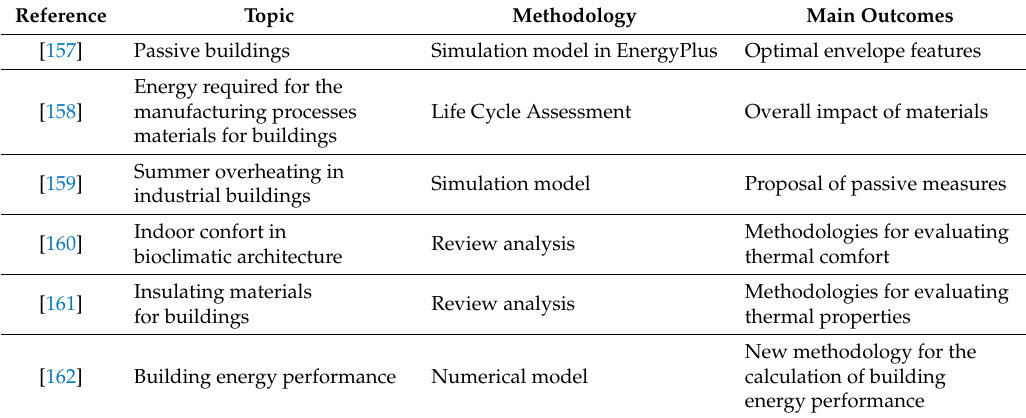
Table 5. Main topics, methodologies and outcomes of the previous SDEWES papers dealing